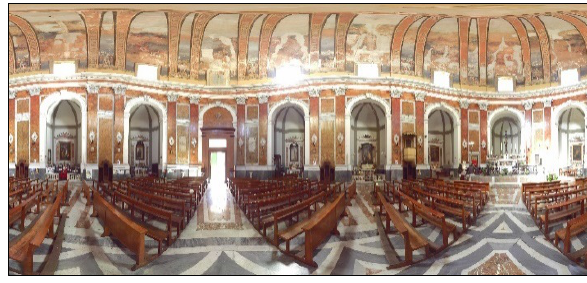
Figure 8. Equirectangular image shot of the center of